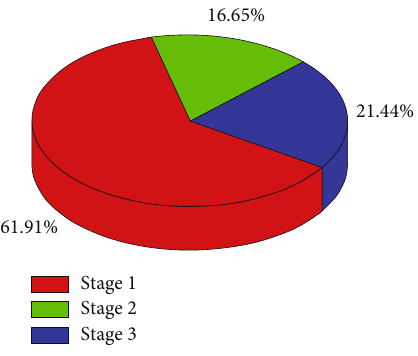
Figure 13: Proportion of axial force increment in each construction